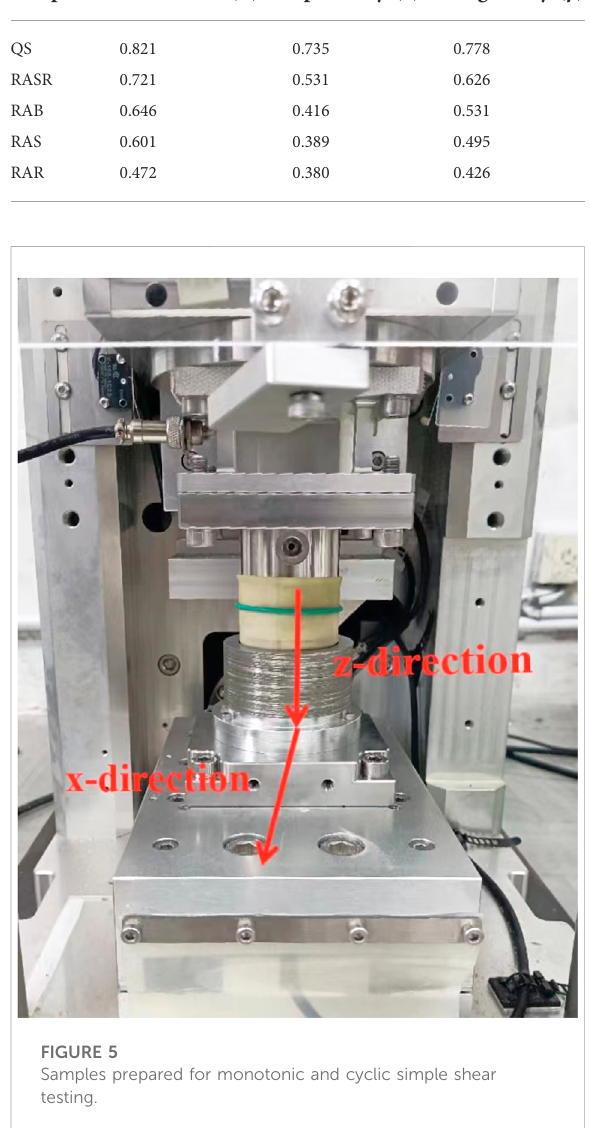
FIGURE 5 Samples prepared for monotonic and cyclic simple shear testing.